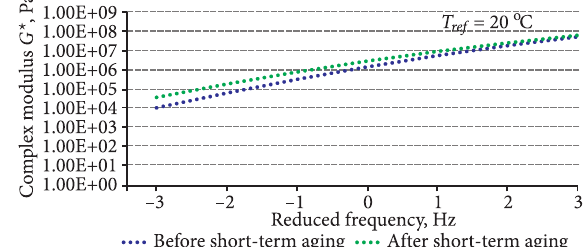
fig. 13. The Complex Shear Modulus of bitumen 50/70 produced by the producer E before and after short-term aging table 2. Requirements to bitumen resistance to rutting based on the values of Dynamic Shear Rheometer (by AASHTO M. 320-10 2013 ) Bitumen Value Limit values, kPa Unaged bitumen ≥1.0 After short-term aging (RTFOT residue)